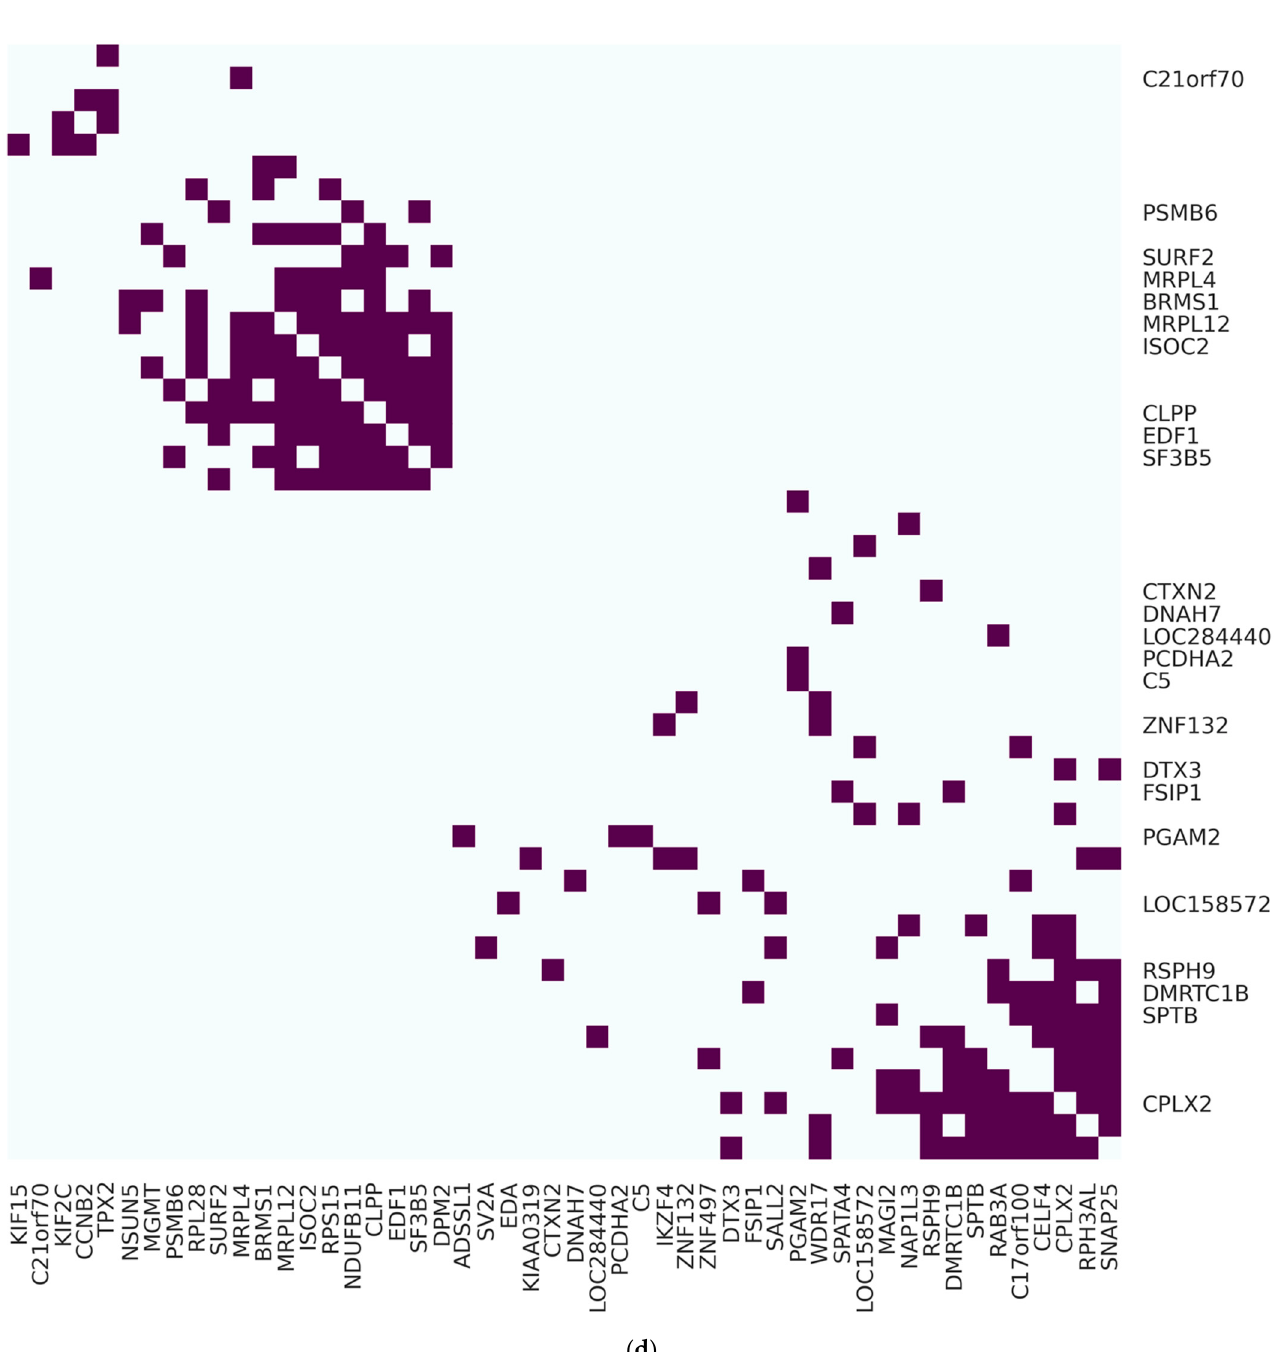
Figure 3. Visualization for most correlated genes regarding POLI expression in network and heatmap layouts: ( a ) Circosplot for 50 most POLI -related genes from 100 genes returned by RFC in CESC; ( b ) Circosplot for 50 most POLI -related genes from 100 genes returned by RFC in PAAD; ( c ) heatmap layout of 50 genes in ( a ); ( d ) heatmap layout of 50 genes in ( b ). For ( c , d ) on the y -axis locations, labels of the POLI -related genes were removed when they were not the top 50 important variables in RFC.